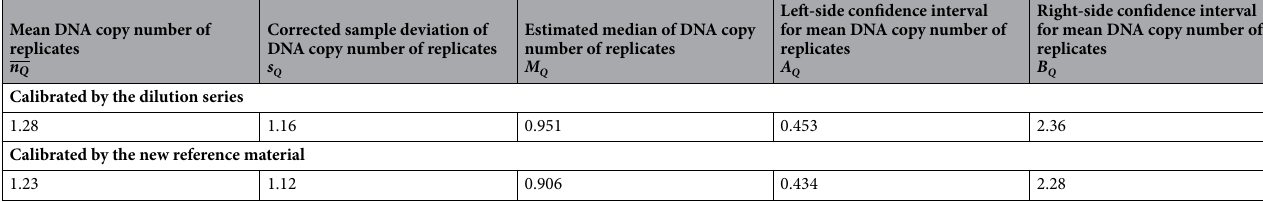
Table 4. Real-time PCR results of target samples to be quantified including undetermined wells as 0 copy.